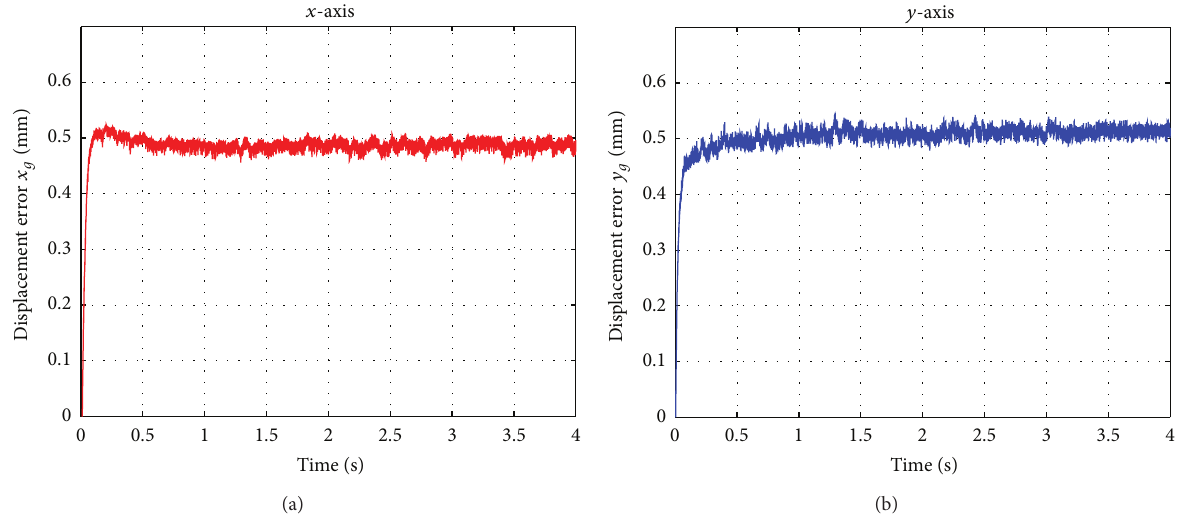
Figure 22: Step response of rotor position of AMB